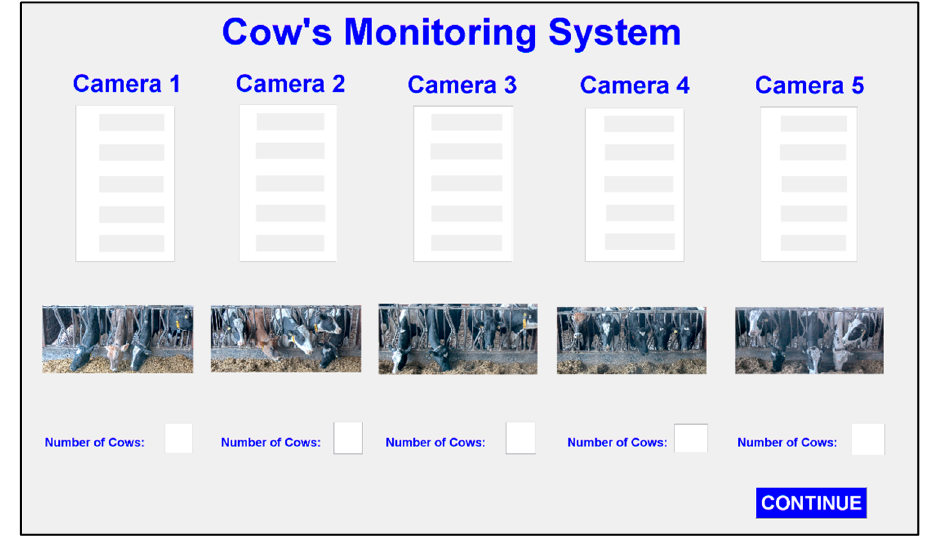
Figure 20. Design of user interface for the proposed system.